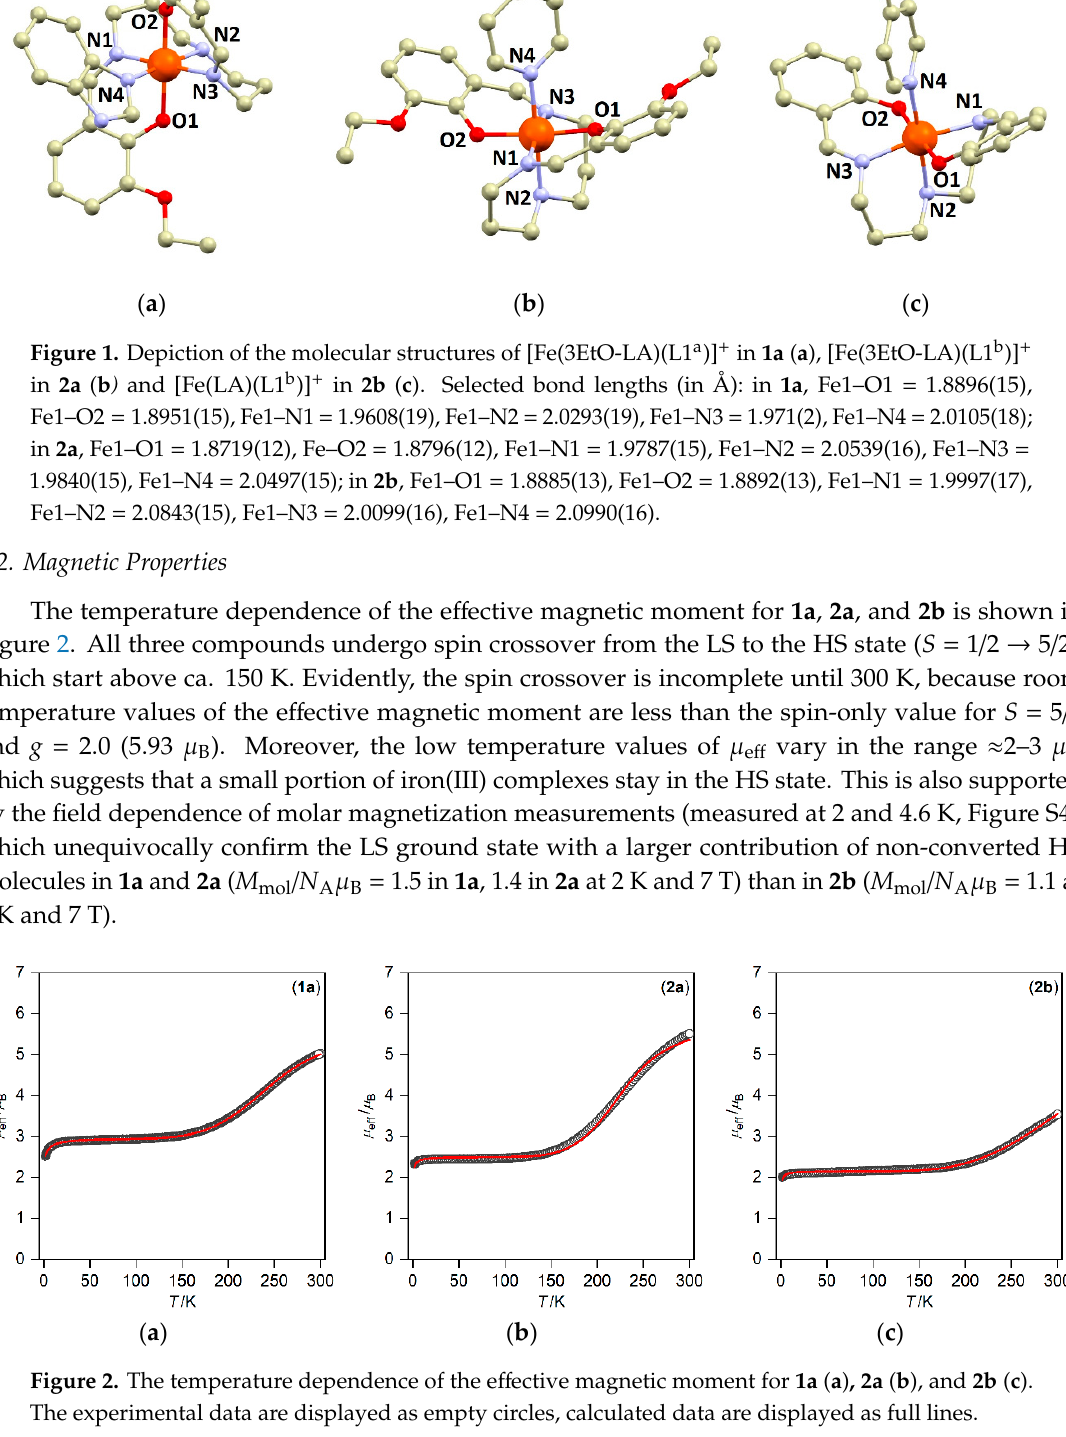
Figure 2. The temperature dependence of the effective magnetic moment for 1a ( a ) , 2a ( b ), and 2b ( c ). The experimental data are displayed as empty circles, calculated data are displayed as full lines.